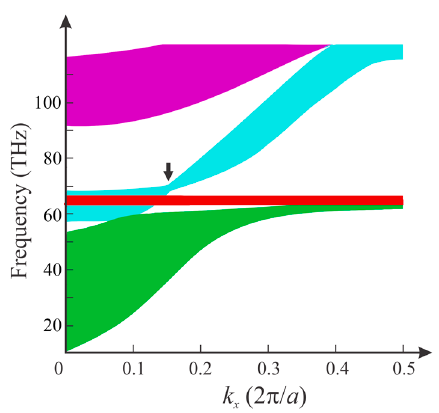
Figure 9. Band structure of the PHC by using full electromagnetic calculation.